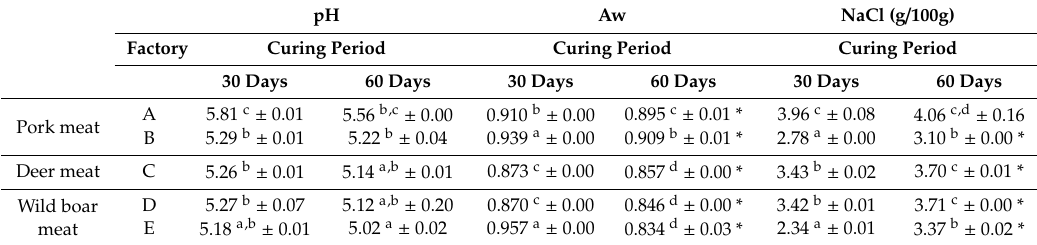
Table 1. Physical-chemical parameters of the studied pork and game fermented sausages. pH Aw NaCl (g / 100g)